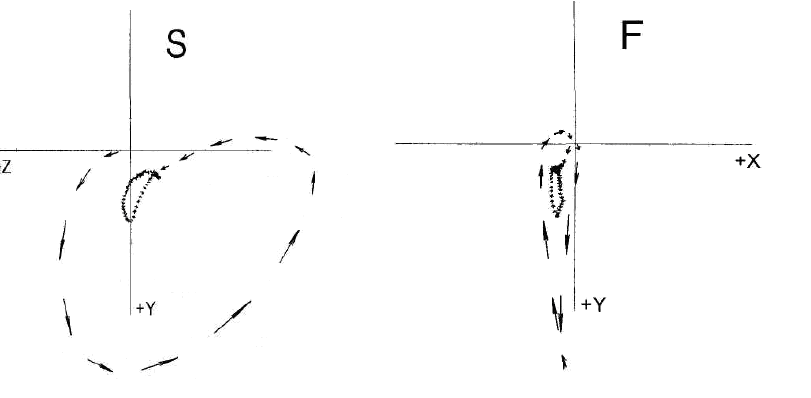
Fig. 1. Typical VCG graphs of gymnasts’ ventricles, whose hearts were predisposed to anaerobic-aerobic loads. (n = 13)